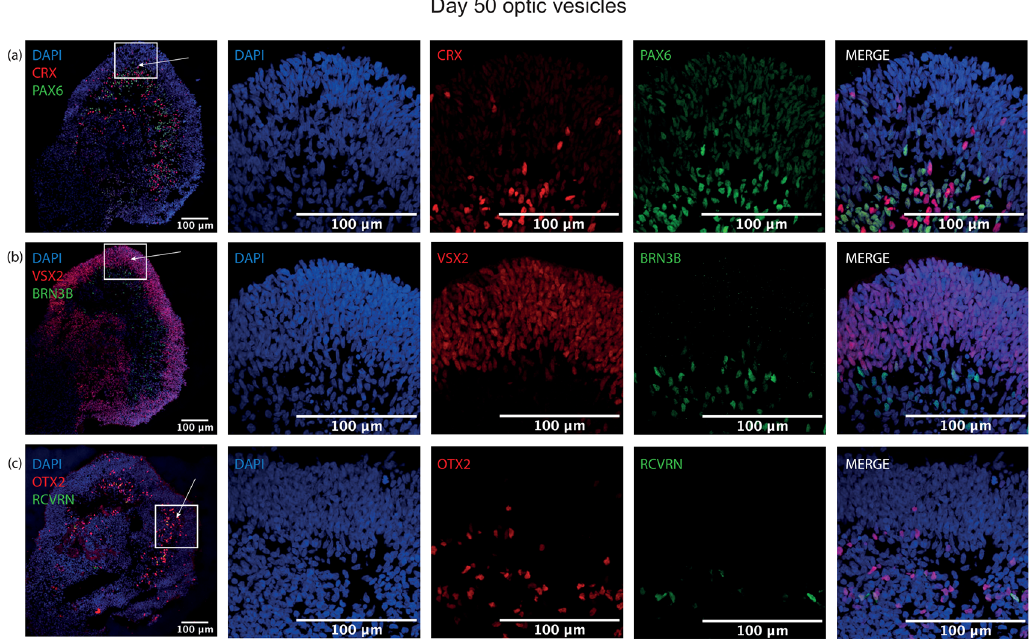
Figure6.Representativeimagesofimmunohistochemistrysectionsofdifferentiatingopticvesiclesatday50. Laminar neuroepithelium thickens at day 50, with differentiating photoreceptor precursor cells detected by (a) CRX expressionstrongestatthebasalaspectbutpresentintheneuroepitheliumcharacterisedbyretinalprogenitorcells expressing (b) VSX2. Retinal ganglion cell marker (b) BRN3B is expressed closer to the centre of the optic vesicle rather than in the neuroepithelial cell layer. (a) PAX6 is expressed in the neuroepithelium and towards its basal aspect, where (c) few OTX2+ cells co-localise with early rod marker Recoverin (RCVRN) also indicative of photore- ceptor precursor cell differentiation.